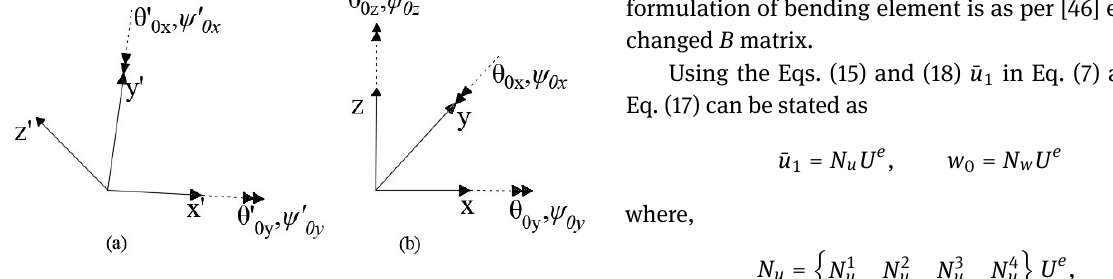
Figure 4: Positive directions for Local and global rotational displace- ments (bending and shear